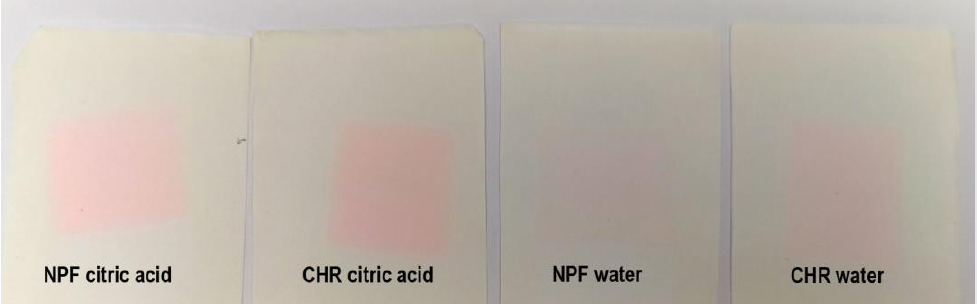
Figure 4. Bleeding of colorants into filter papers from test pieces printed with PP-31 TC ink.